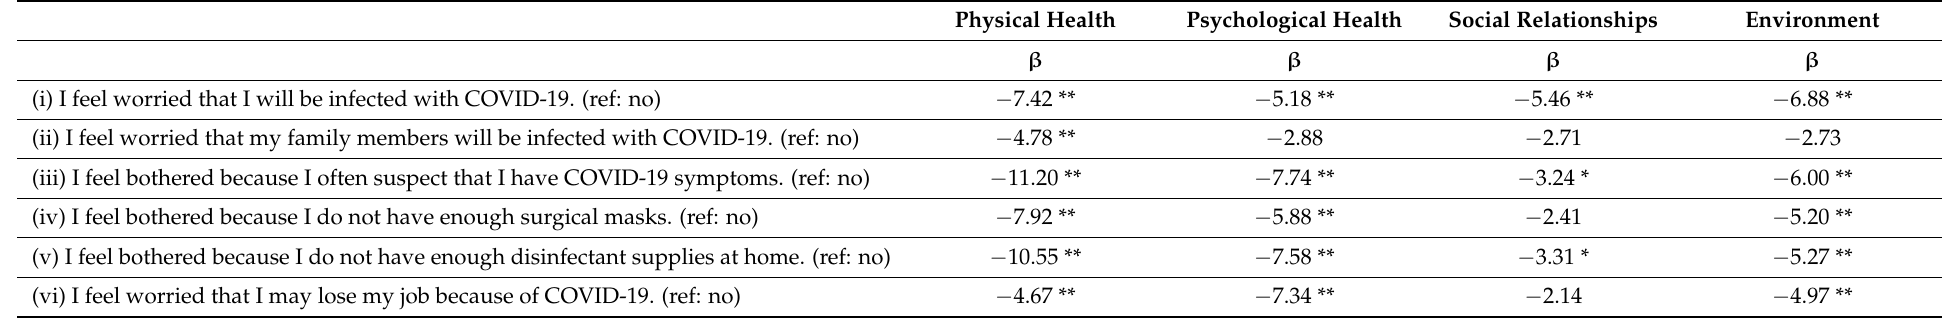
Table 3. Results of multiple linear